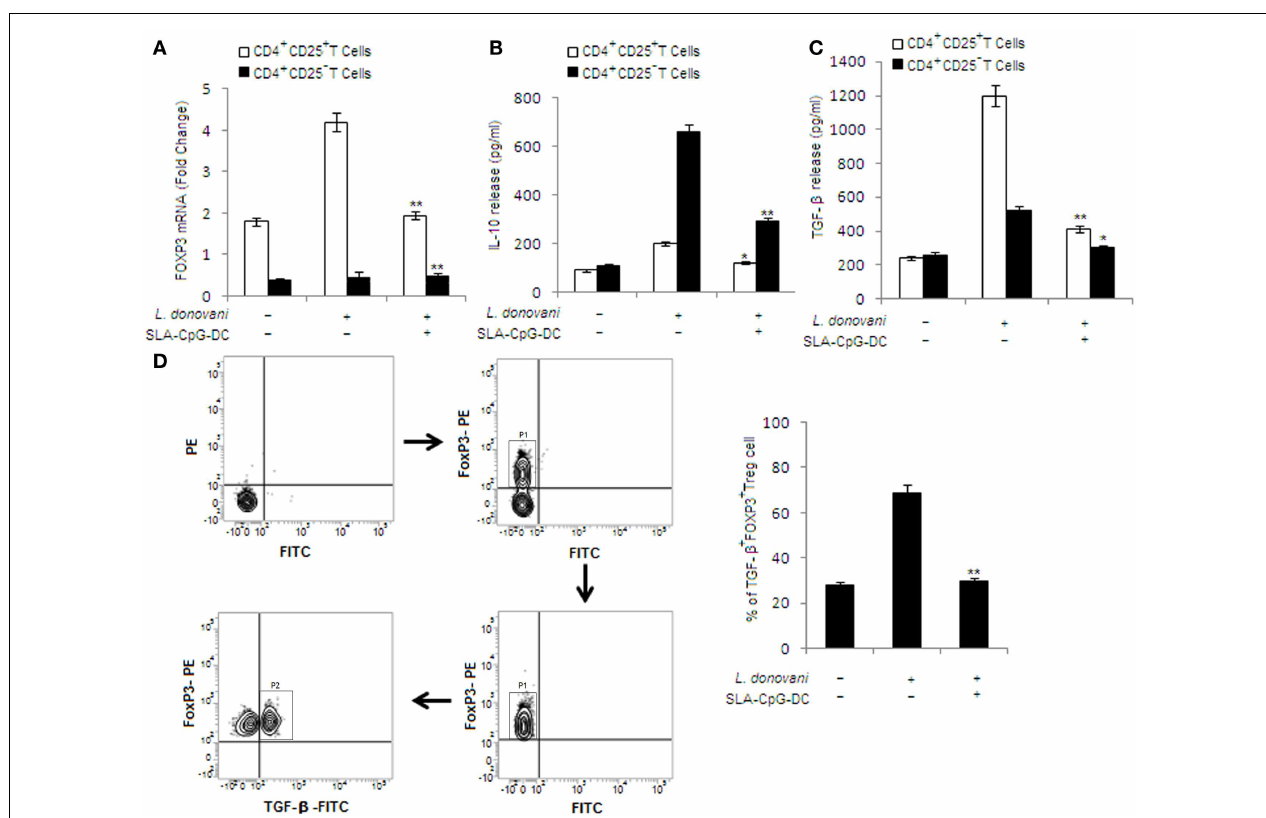
TGF- β and Foxp3 (D) , which was performed as mentioned in Section “Materials and Methods,” and analyzed by Flow cytometry. Magnetically purified CD4 + CD25 + cells were analyzed for FoxP3-PE staining to detect FoxP3 + CD4 + CD25 + cells (P1 gated cell population in the sorting scheme). These FoxP3 + CD4 + CD25 + cells were further analyzed forTGF- β -FITC staining to detectTGF- β + FoxP3 + CD4 + CD25 + T cells (P2 gated cell population in the sorting scheme).The bar graphs represent the mean dot plot values based on the region encircling positive cells from three independent experiments. ** P < 0.001 and * P < 0.05, compared withT regulatory cells isolated from infected mice.The data represent the mean ± SD of data from three independent experiments, which yielded similar